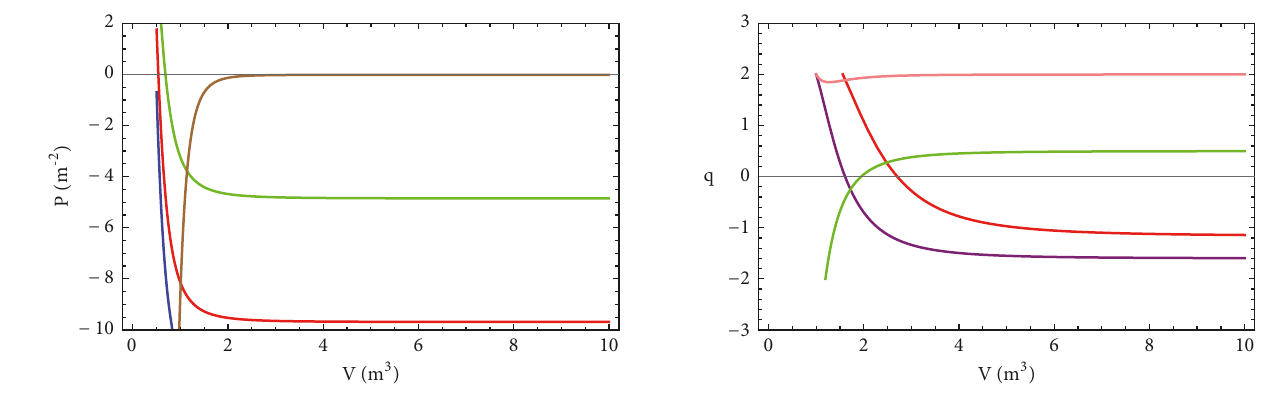
Figure 3: Plots of 𝑞 versus 𝑉 for 𝛾 = −2,𝐴 = 2,𝛼 = 0.1, 𝑑 = 1 with 𝑍 = −2 (purple), −1.3 (red), 0 (green), and 2 (pink).